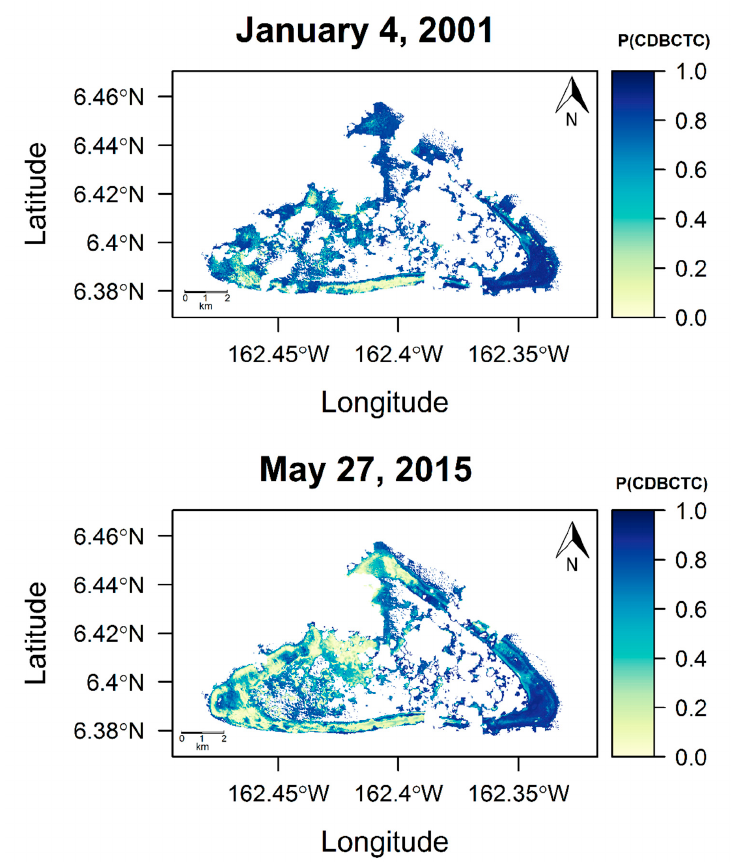
Remote Sens. 2019 , 11 , x FOR PEER REVIEW 17 of 31 Figure 7. Posterior probability map for the Kingman Reef area of interest (top, 2001 and bottom, 2015).